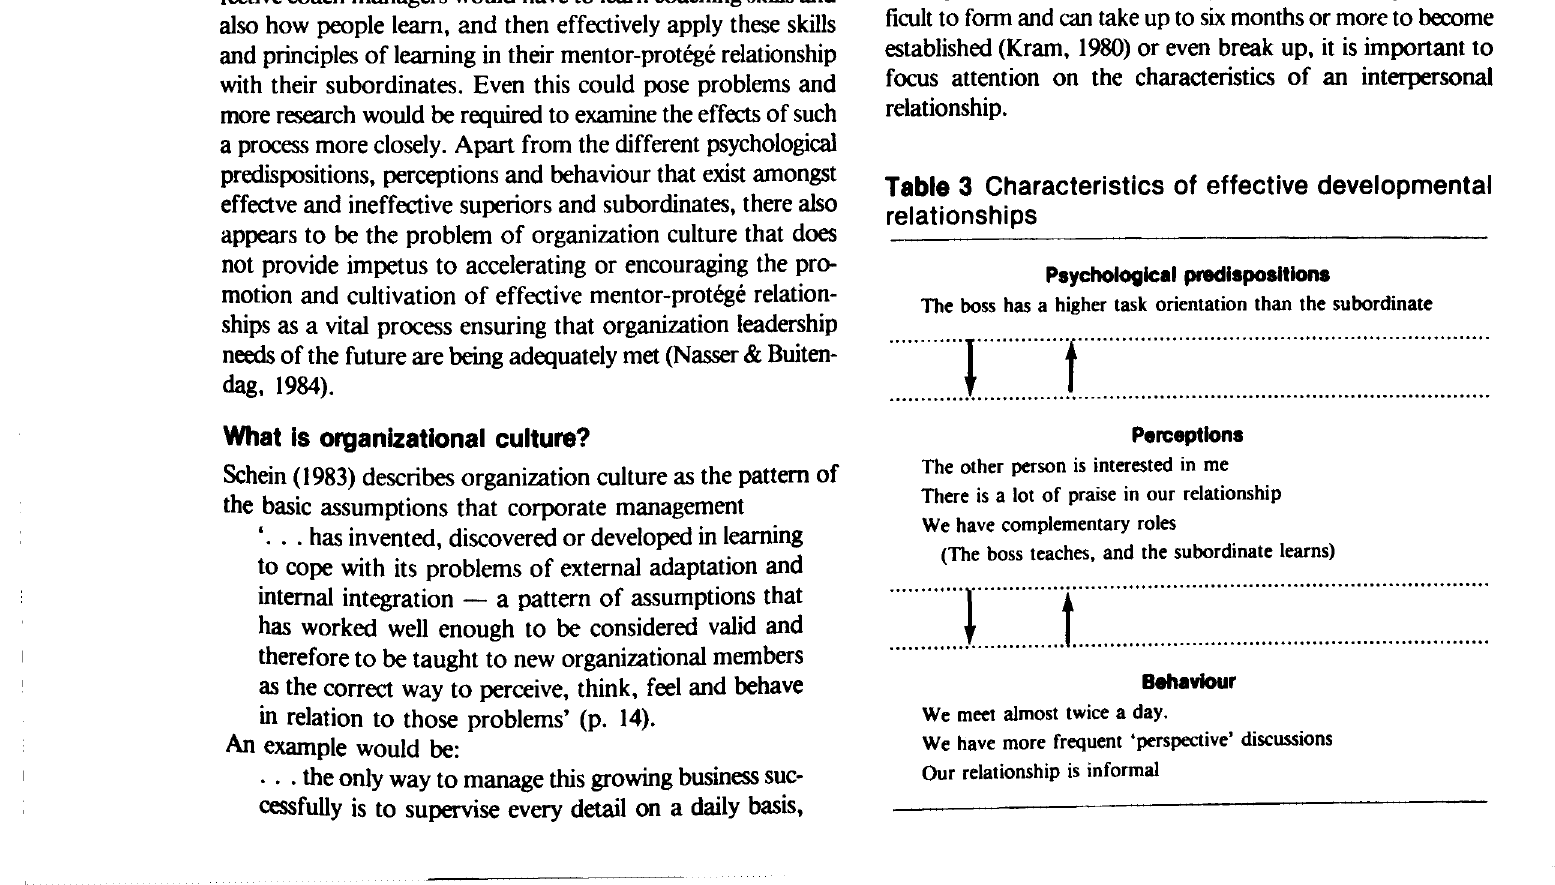
Table 3 Characteristics of effective developmental